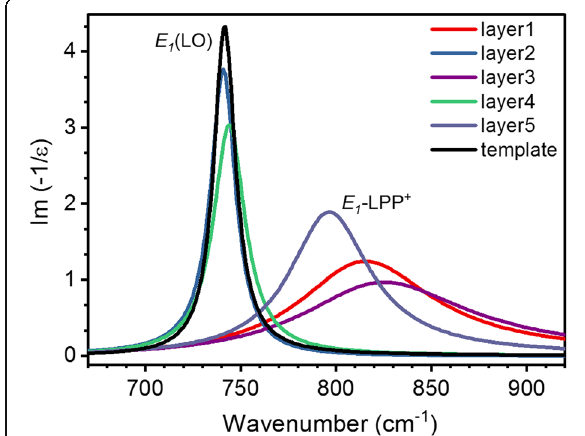
Fig. 8 Calculated imaginary part of dielectric function obtained for each analyzed GaN layer from the best-fit data analysis